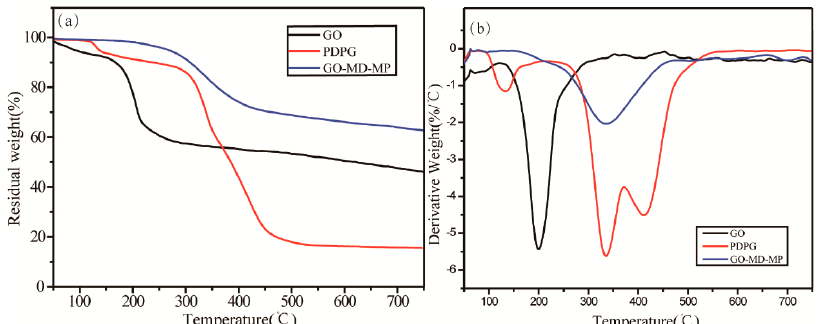
Figure 8. The thermogravimetric analysis (TGA) ( a ) and derivative weight (DTG) ( b ) curves of GO, PDPG, and GO-MD-MP.